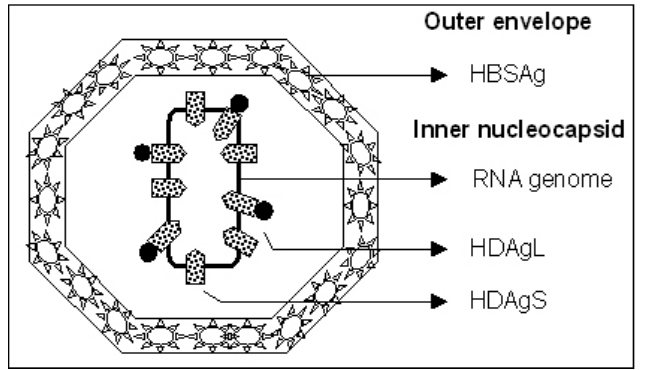
FIGURE 4 . Schematic representation of the HDV virion. It has an outer envelope, comprised of HBSAg, and an inner nucleocapsid. The nucleocapsid contains the RNA genome and two forms of HDAg: HDAgL (the long form) and HDAgS (the short